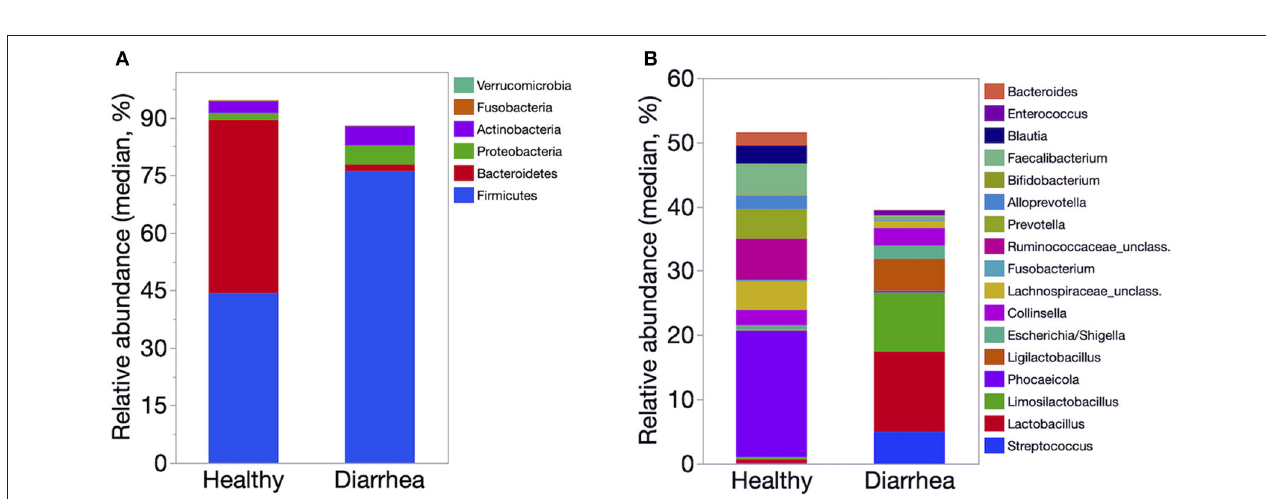
FIGURE 4 | Median relative abundance of predominant bacteria at the phylum (A) and genus (B) level identified in feces of healthy ( n = 20) and diarrheic dairy calves ( n = 31). The 6 most abundant phyla and 17 most abundant genera are